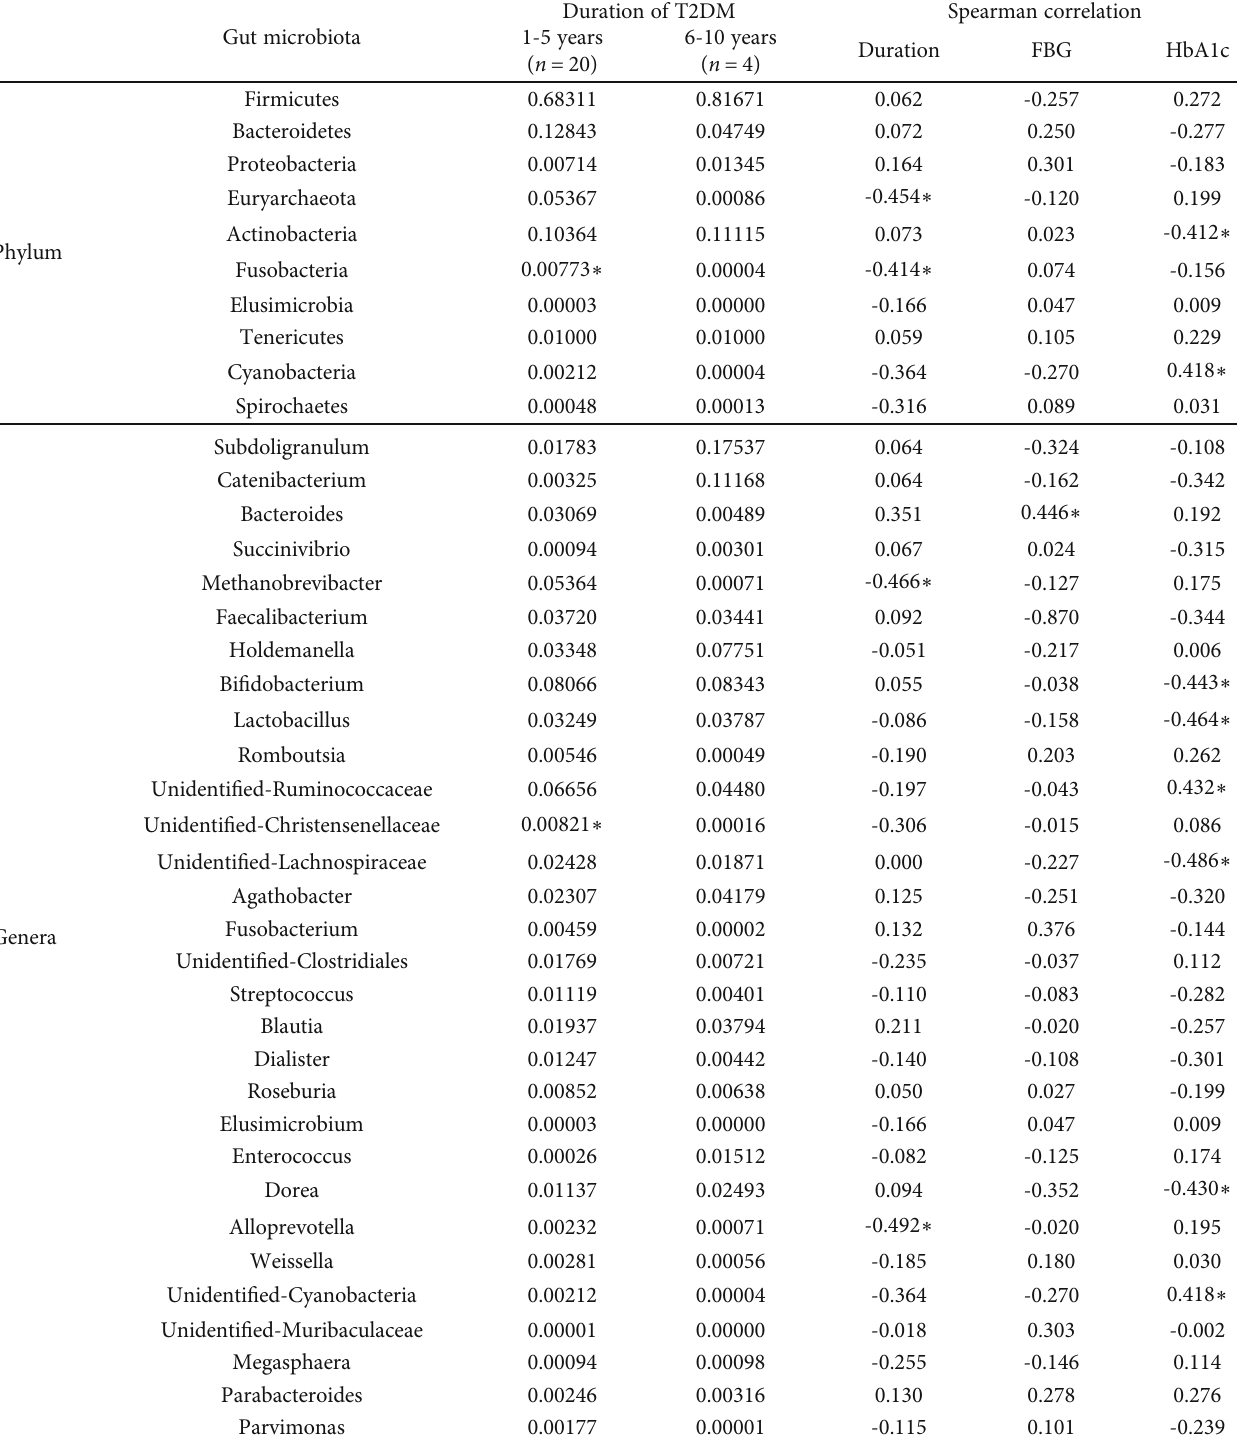
Table 4: Link of relative abundance microbiota and